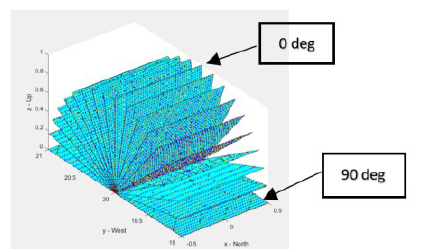
Figure 9 – All the 19 planar target orientations versus a terrestrial